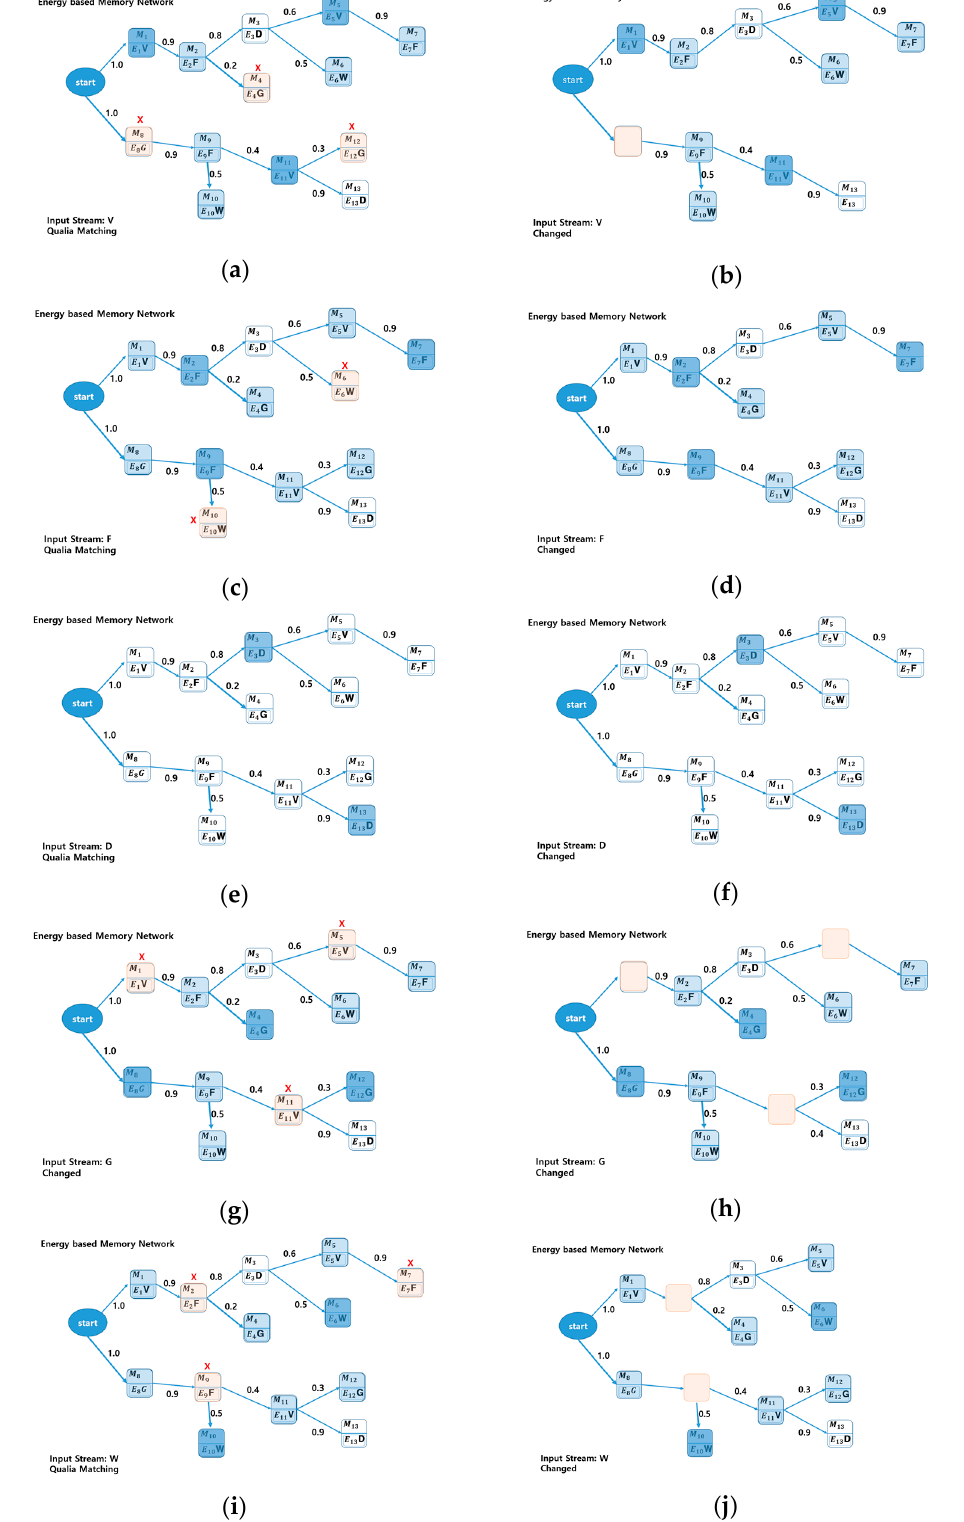
Figure 13. Qualia Matching and Activated Energy-based Memory network ( a ) Qualia Matching with ERS signal V ( b ) The